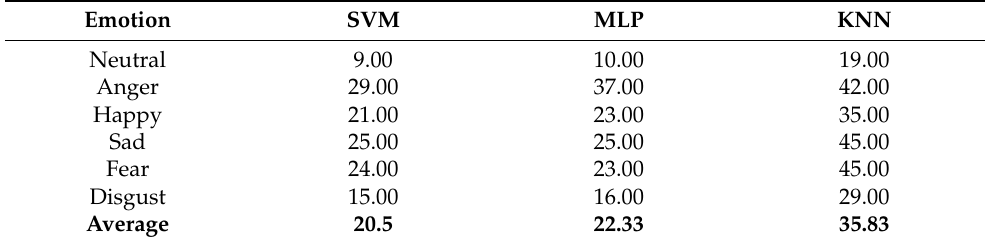
Table 3. Percentage EER using SVM, MLP, and KNN classifiers using the ESD